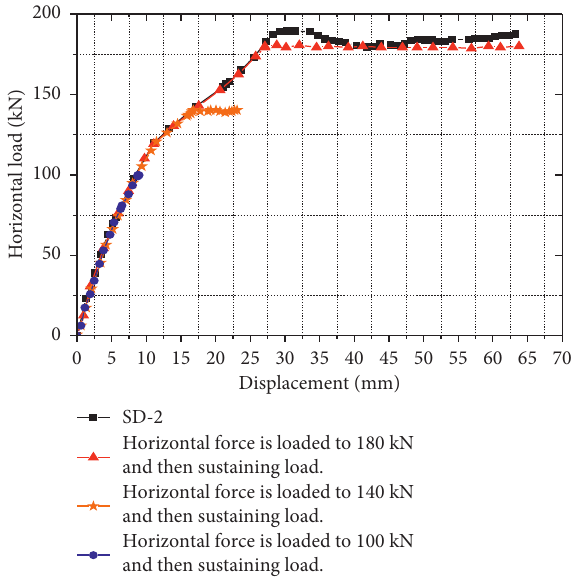
Figure 19: Load-displacement curve of the specimen under sus- tained